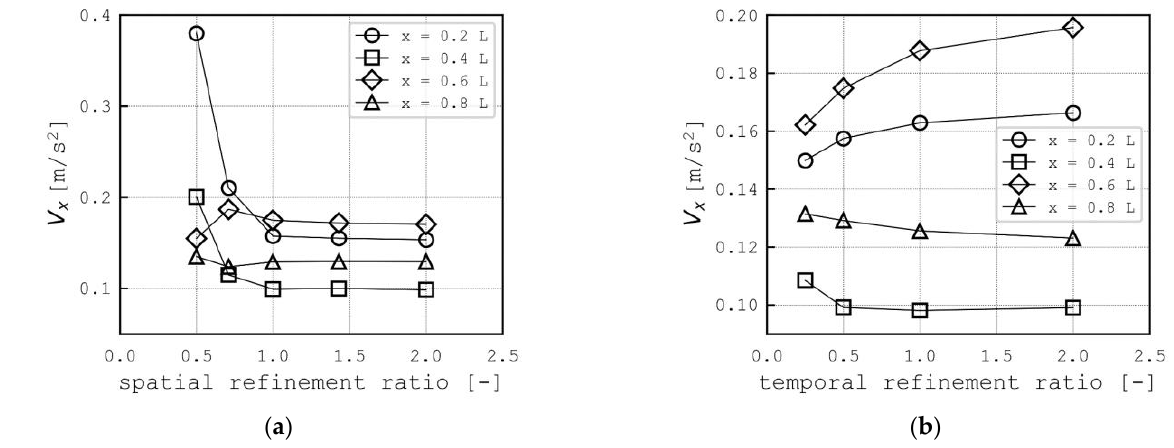
Figure A2. Prediction of 𝒗 𝑥 on sample points resolution at flow time = 2 s by ( a ) grids with different spatial refinement ratio and ( b ) same grid with different temporal refinement ratio. Table A2. Sample uncertainty analysis by different spatial resolution.